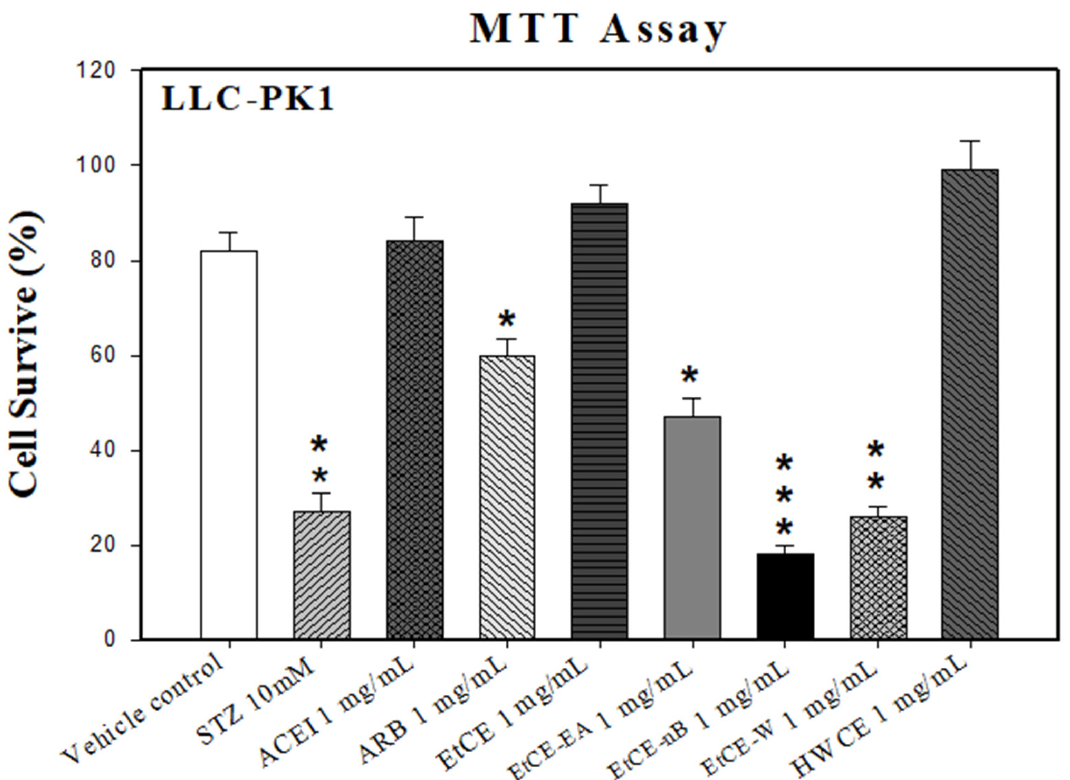
Figure 1. Viability of Inonotus obliquus fruit bodies extracts (IOEs) in LLC-PKI cells. The LLC-PK1 cells were cultured in Nine groups; vehicle control, STZ (10 mM), ACEI (1 mg/mL), ARB (1 mg/mL), EtCE: Ethanol crude extract of Inonotus obliquus fruit bodies (1 mg/mL), EtCE-EA: Ethyl acetate layer after water-ethyl acetate separation from ethanol crude extract (1 mg/mL), EtCE-nB: n-butanol layer after water-n-butanol separation from ethanol crude extract (1 mg/mL), EtCE-W: water layer after water-n-butanol separation from ethanol crude extract (1 mg/mL) and HWCE: hot water crude extract of Inonotus obliquus fruit bodies (1 mg/mL), for 72 h alone and cell viability was observed. The cell cytotoxicity was determined by MTT. Each value represents the mean ± SD of three replicated experiments, and the results are expressed as population growth. *: p < 0.05, **: p < 0.01 and ***: p < 0.001 as compared with the vehicle control.